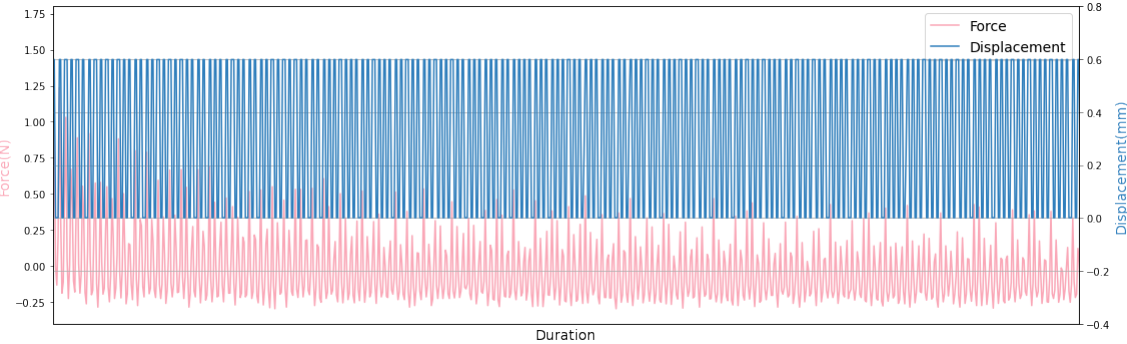
Figure 10. The force-displacement diagram for the first six minutes of 30 min experiment